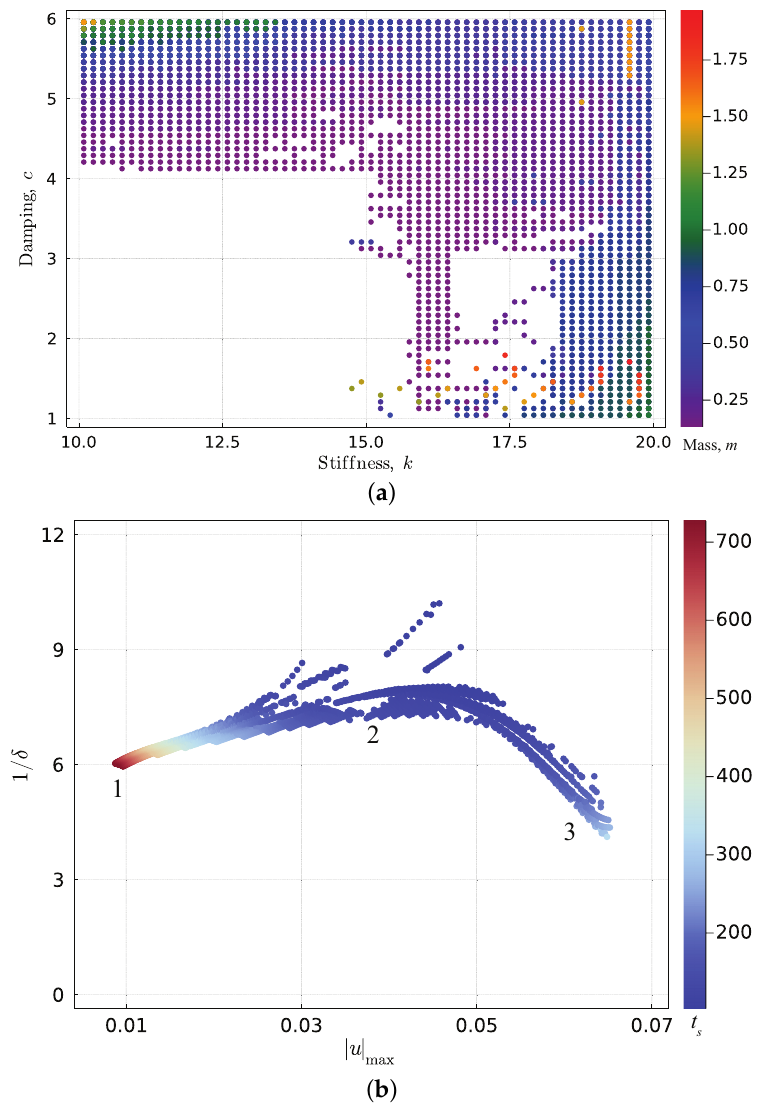
Figure 2. The Pareto set and front of the m − c − k termination design of the elastic rod. ( a ) Pareto set. ( b ) Pareto front. Design parameters m ∈ [ 0.1,2.0 ] , c ∈ [ 1.0,6.0 ] , k ∈ [ 10.0,20.0 ] . The labels “1”, “2”, and “3” indicate the regions where optimal terminal displacement, balanced performance of objective functions, and optimal damping performance are achieved.